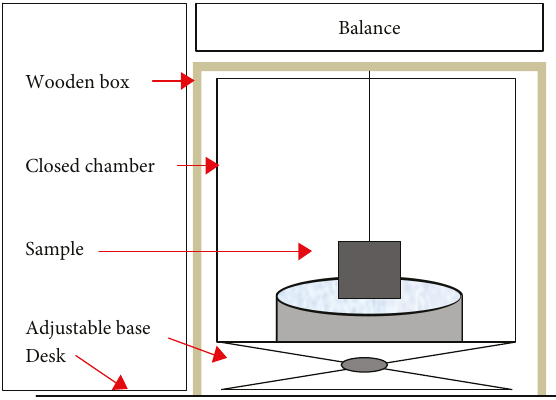
Figure 2: Setup for imbibition and vapor absorption